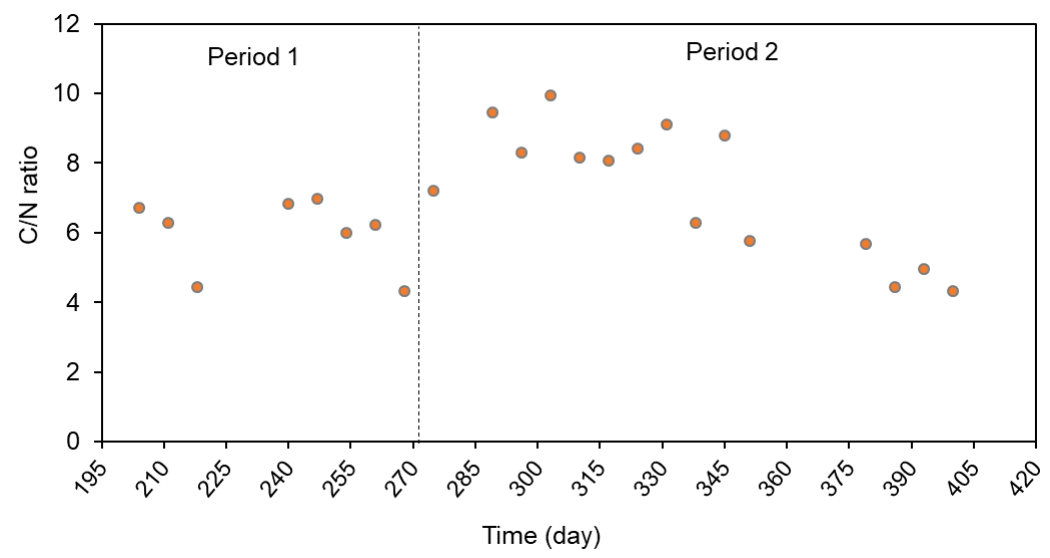
Figure 7. C / N ratio of the anaerobic digester influent (pretreated microalgal biomass) over the experimental periods 1 (HRT of 20 days) and 2 (HRT of 32 days).